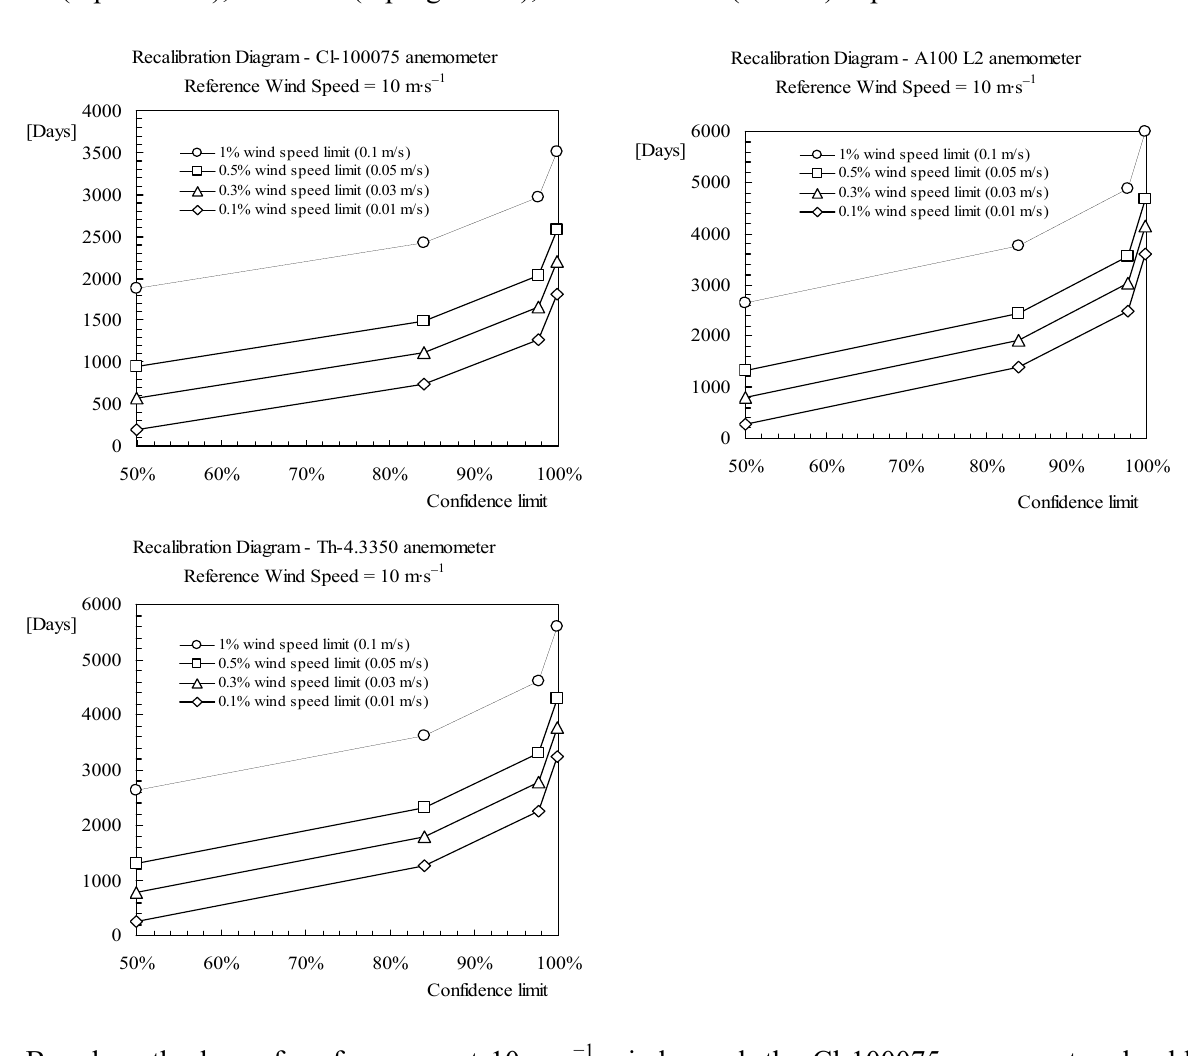
Figure 3. Recalibration diagram proposed for the IDR/UPM Institute’s Cl-100075 (top left side), A100 L2 (top right side), and Th-4.3350 (bottom) cup